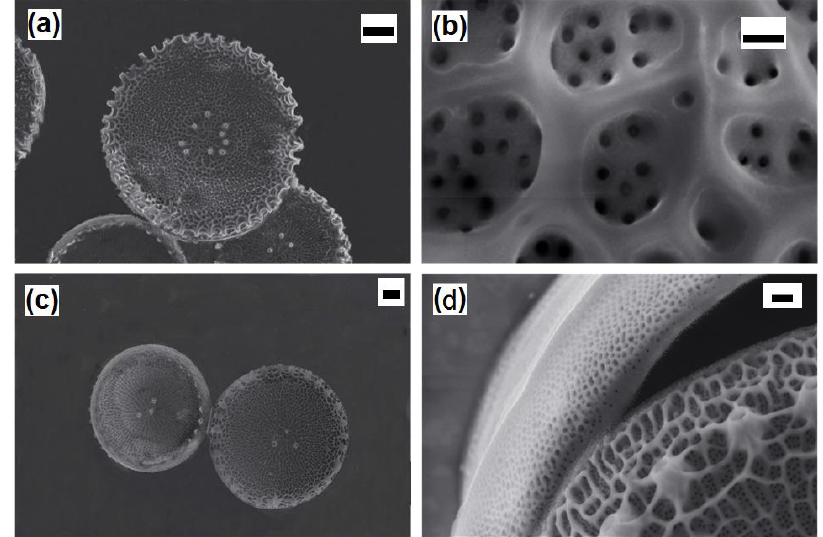
Figure 4. SEM images of ( a ) the whole frustule valves of Thalassiosira weissflogii ; ( b ) the pore patterning after amino-silanization; frustule valves; ( c ) valves-girdle nanotexturing; ( d ) after mercapto-silanization. After both the chemical modification, the pores are not occluded. Markers: ( a ) 2 µm; ( b ) 100 nm; ( a ) 1 µm; ( d ) 200 nm.